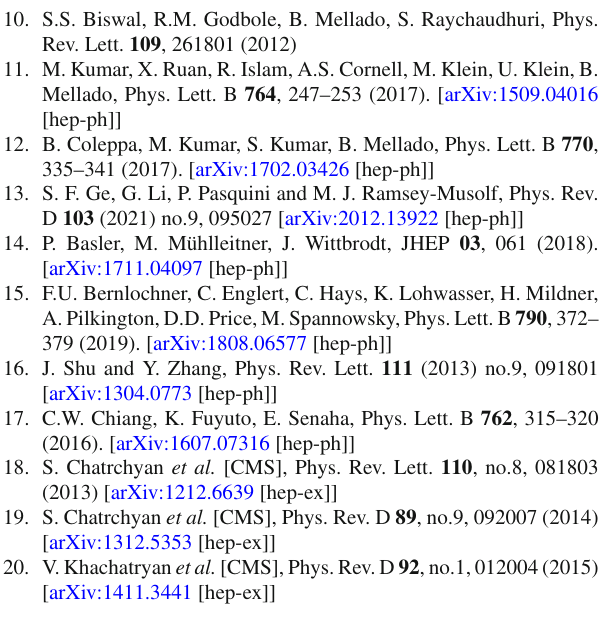
rated them. At the detector level we also observed the similar separation of signal and background events from the DNN algorithm used in this